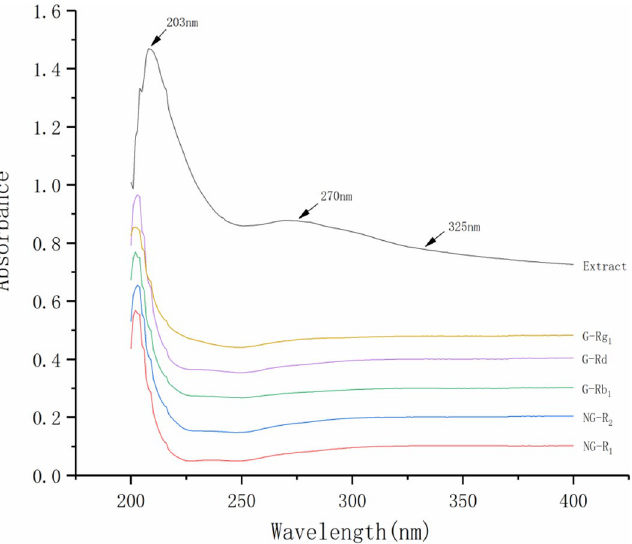
Figure 2. UV spectrum of five investigated saponins reference standards and P. notoginseng extract. G-Rg